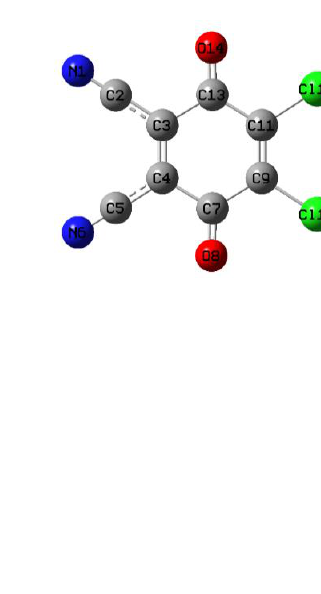
Figure 4. Optimized structures of KT, DDQ, and TCNQ.